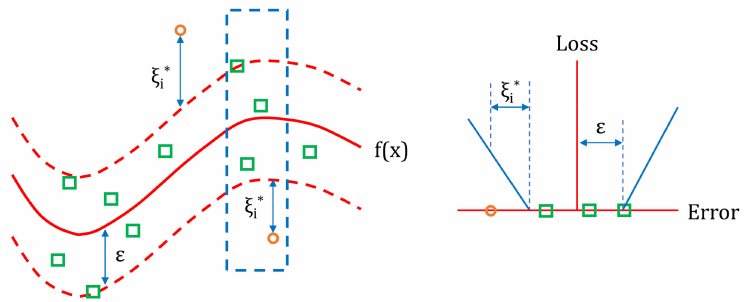
Figure 3. Example of Support Vector Regression. Errors can be neglected if they are less than ε , while larger deviations are